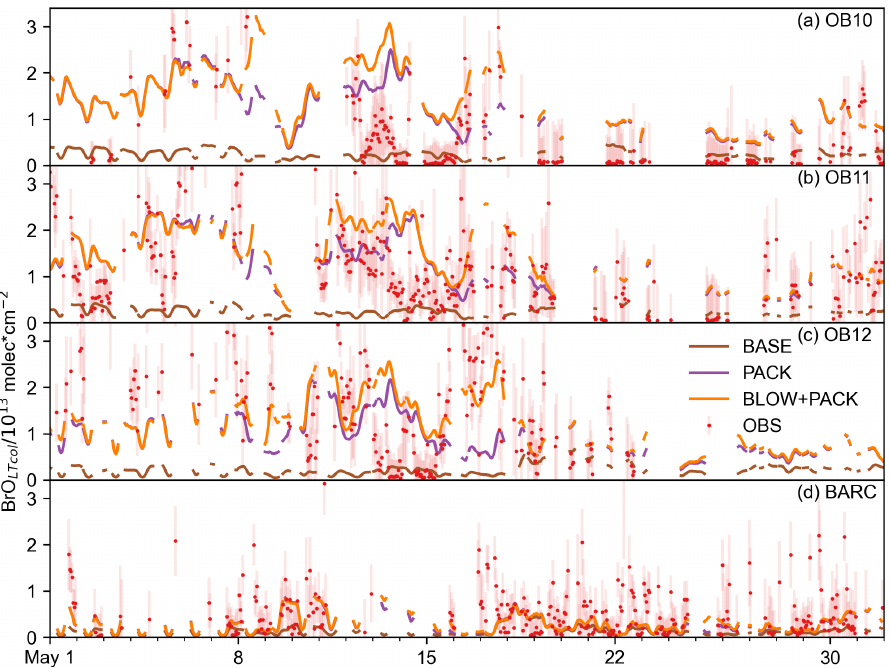
Figure 6. May hourly BrO LTcol time series. Hourly time series of BLOW + PACK, PACK, and BASE BrO LTcol on (a) O-Buoy 10, (b) O- Buoy 11, (c) O-Buoy 12, and (d) BARC at Utqia˙gvik in the 2015 Arctic spring. Observations and error bars in red, BASE BrO LTcol in brown, PACK BrO LTcol in purple, and BLOW + PACK BrO LTcol in orange. All BrO LTcol plotted continuously except for gaps where dSCDO 4 > 1 × 10 43 molecules 2 cm − 5 .